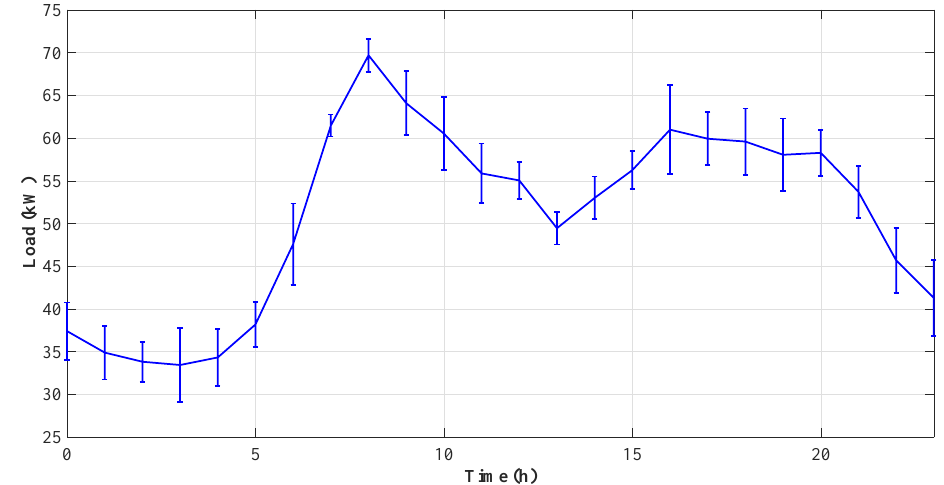
Figure 2. Weekly mean boat demand with standard